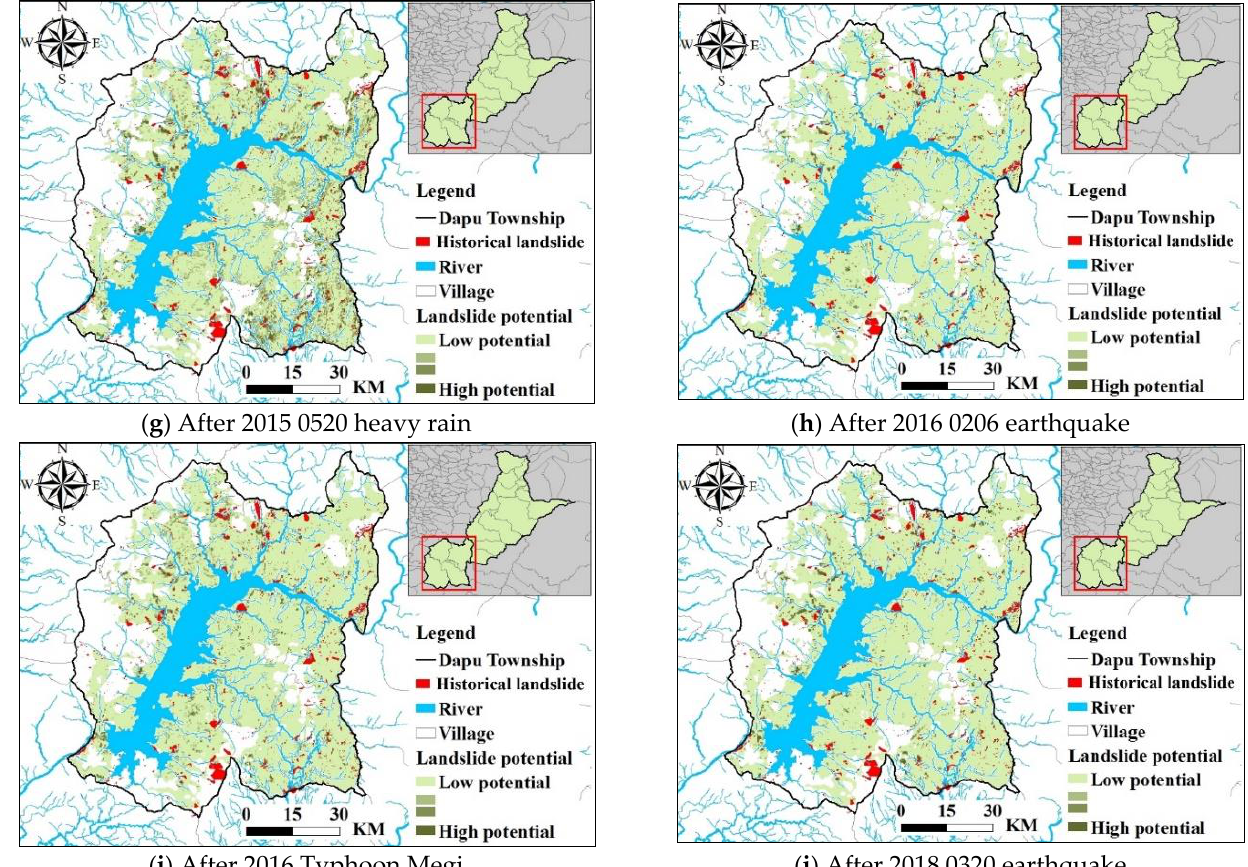
Figure 11. Landslide potential map of Dapu Township after rainfall or earthquakes overlapped by historical landslides.